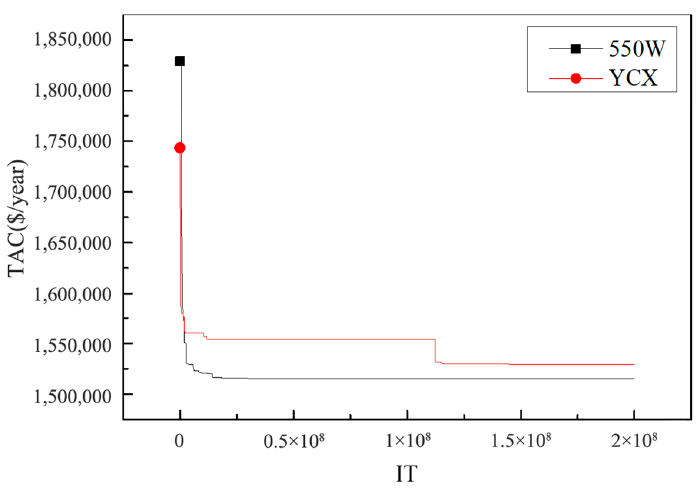
Figure 7. TAC curve of the participatory evolutionary strategy and TAC curve of original algorithm for Case 2.